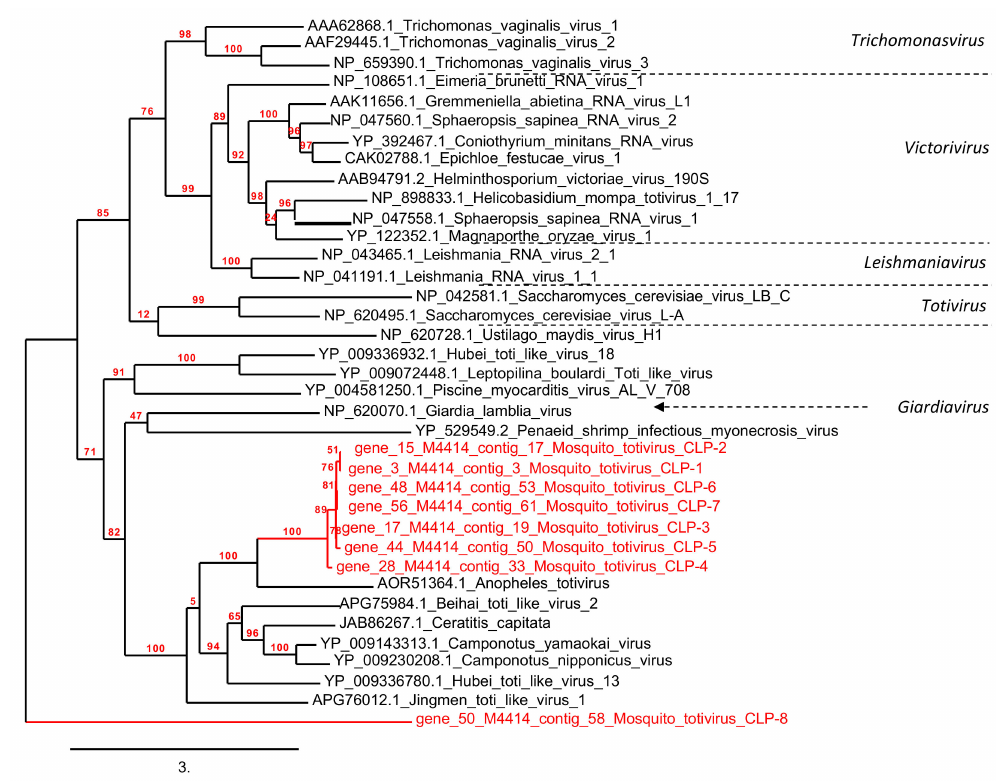
Figure 6. Phylogenetic analysis of mosquito Totivirus CLP-1 to CLP-8 compared to other Totiviridae